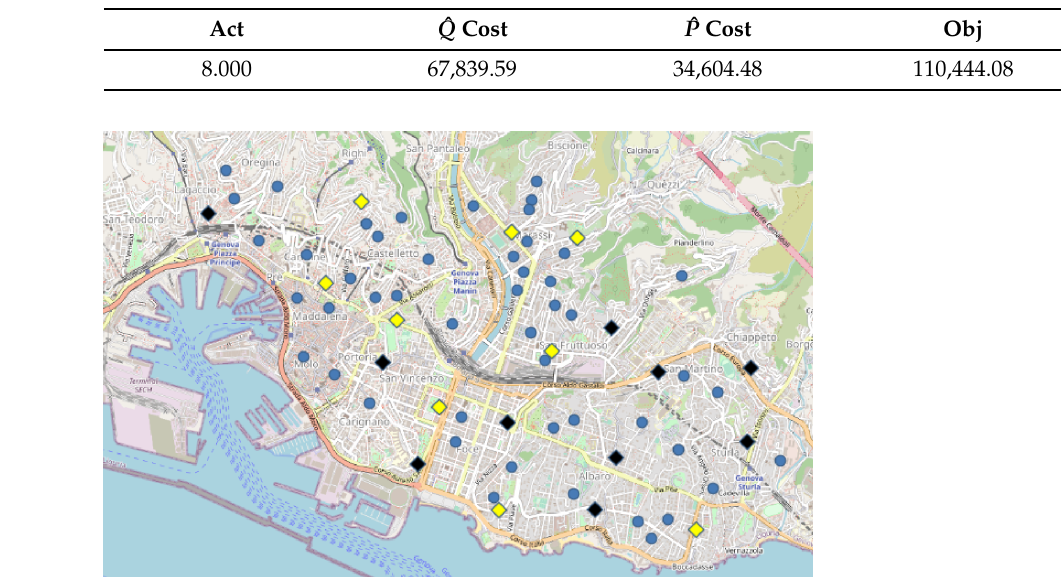
Table 14. Cost components of the objective function.